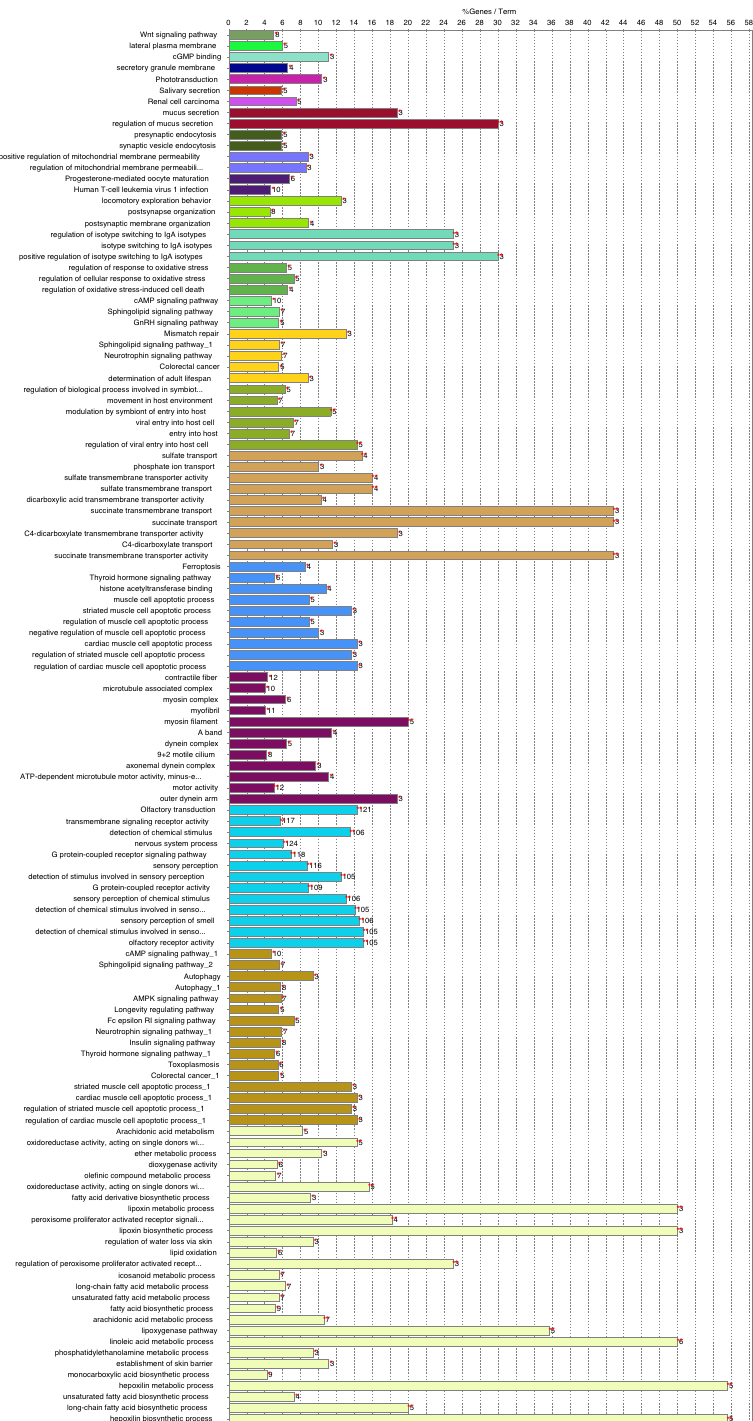
Figure 2. Functional annotation groups for genes associated with adaptation to high altitude. See Table S4 for